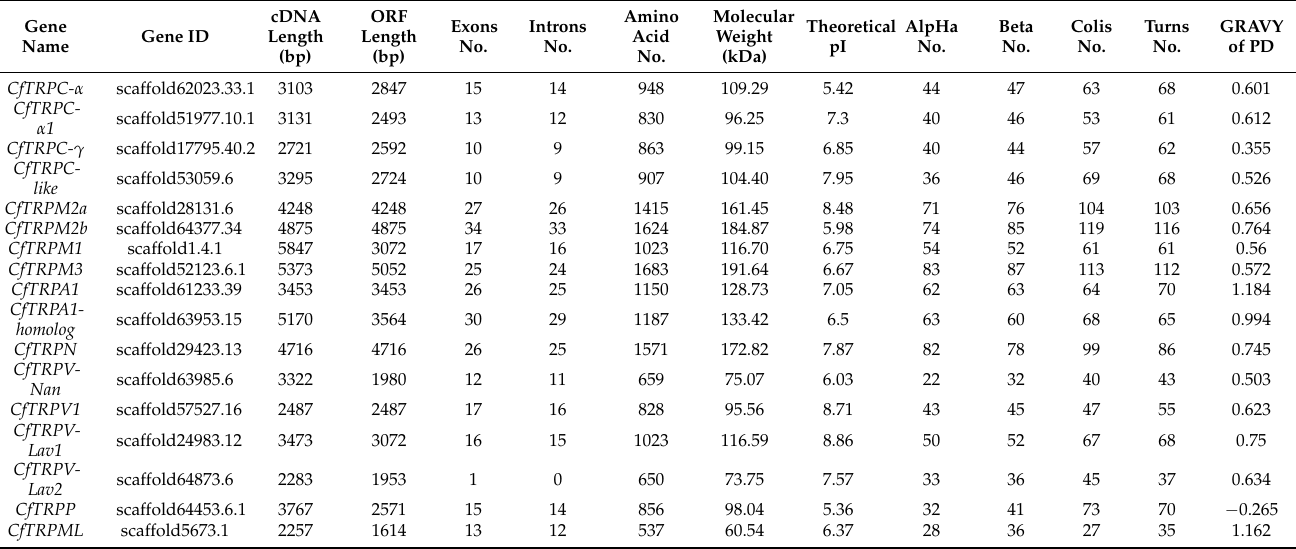
Table 2. Sequence characteristics of TRP gene family of C. farreri .